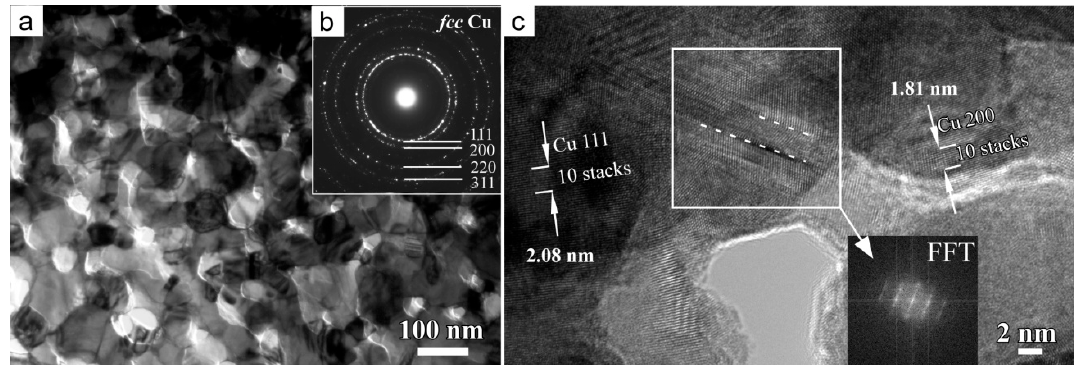
Figure 4. Cross-sectional bright field TEM image (BFI) ( a ), selected area diffraction pattern (SADP) ( b ), and high-resolution transmission electron microscope (HRTEM) image ( c ) of the internal part of nanoporous Cu substrate after free immersion in ethanol for 72 h. The dash lines in the frame marks the position of the interface of twin boundaries in the Cu ligaments and the corresponding fast Fourier transform (FFT) pattern is inserted in c.